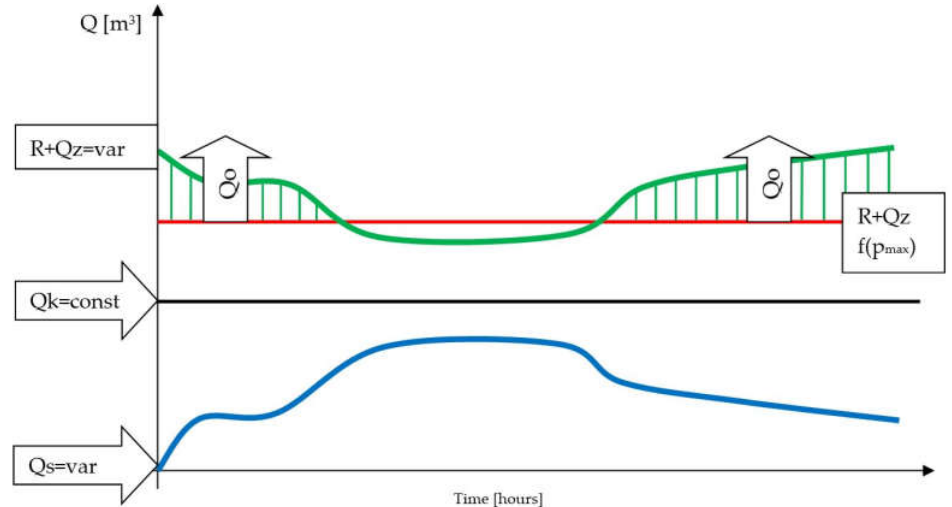
Figure 2. Graph of traditional operating process of piston compressor.